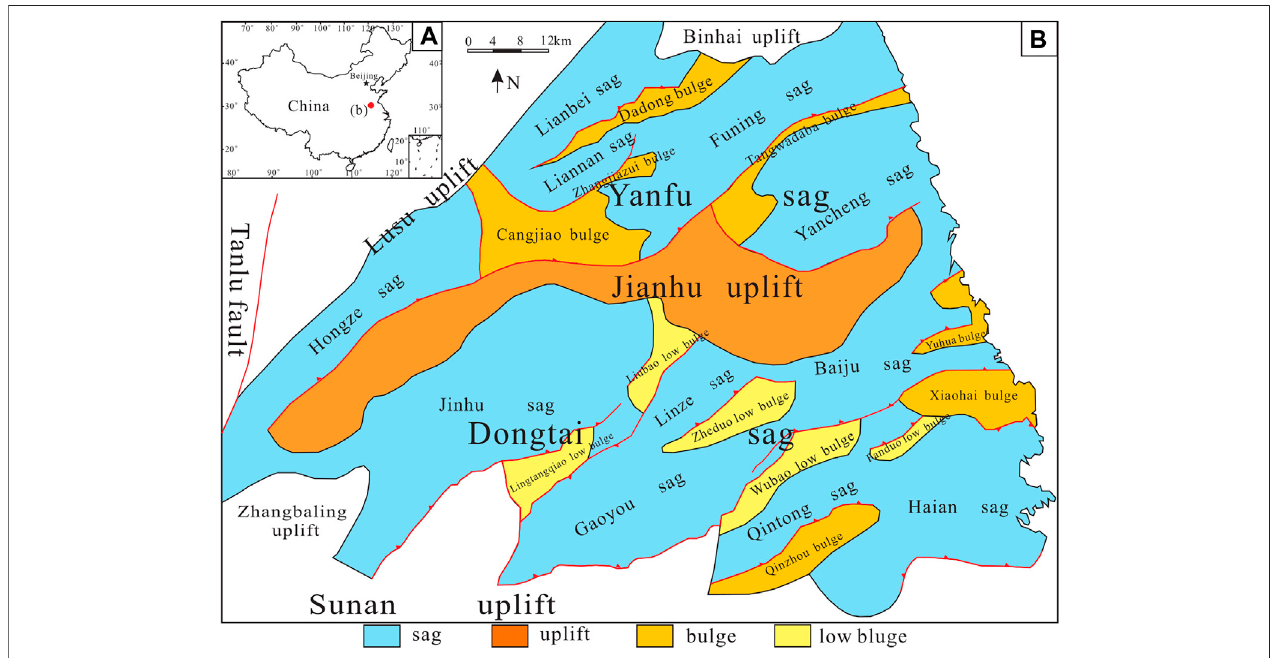
FIGURE1| TectonicunitsoftheNorthJiangSuBasin. (A) LocationofNorthJiangSuBasininChina; (B) HuawaareaislocatedintheeastofGaoyousag,thesouth of North JiangSu Basin.